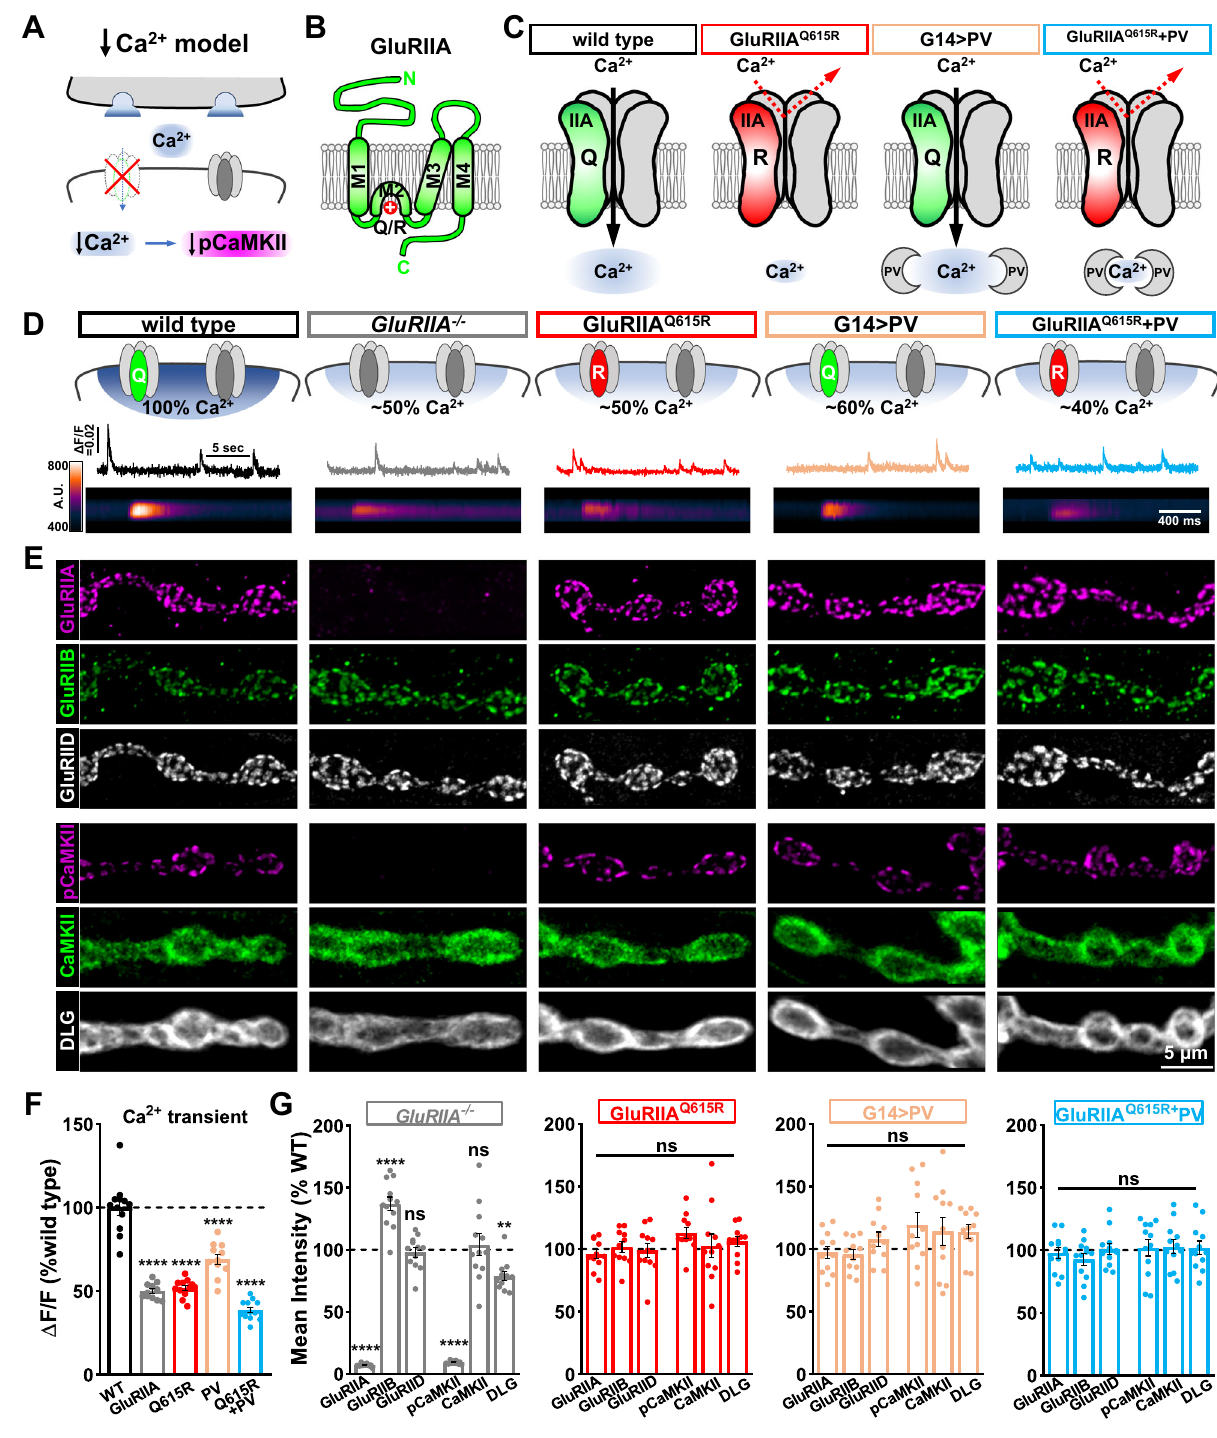
due to loss of GluRAs (Fig. 2D, F). Importantly, while GluRA and GluRB levels were unchanged in GluRIIA Q615R mutants (Fig. 2E, G), a similar ~50% reductionin postsynapticCa 2+ was observed thatwas statistically indistinguishable from GluRIIA null mutants (Fig. 2D, F). This demon- strates that the GluRIIA Q615R allele reduces postsynaptic Ca 2+ in fl ux to thesamelevelsfoundin GluRIIA mutantswithoutalteringpostsynaptic GluR abundance. Finally, we assayed pCaMKII levels in GluRIIA Q615R mutants and found no signi fi cant difference in either total CaMKII or, importantly, pCaMKII levels (Fig. 2E, G). Thus, Ca 2+ in fl ux through GluRA receptors does not modulate CaMKII